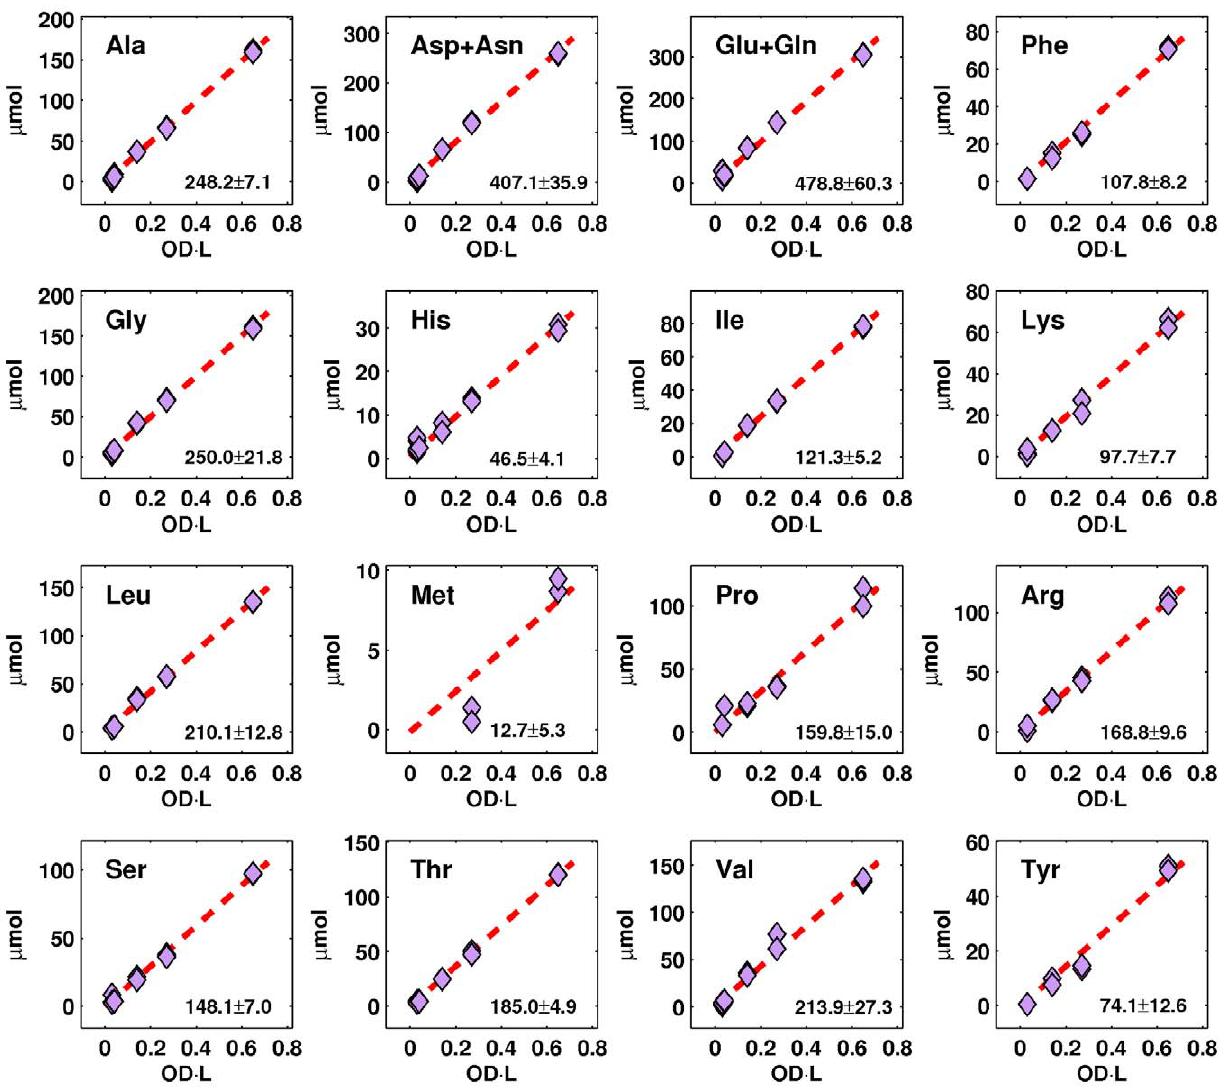
Figure 3. Amino acid composition of the biomass at different optical densities. The values represent total cellular content, including protein residues and free metabolites. The good linear correlations imply that the average (normalized) cellular content of each amino acid remains reasonably constant throughout growth. Due to experimental limitations, only combined values could be obtained for aspartate and asparagine as well as for glutamate and glutamine. Measurements for cysteine and tryptophan could not be reliably obtained.